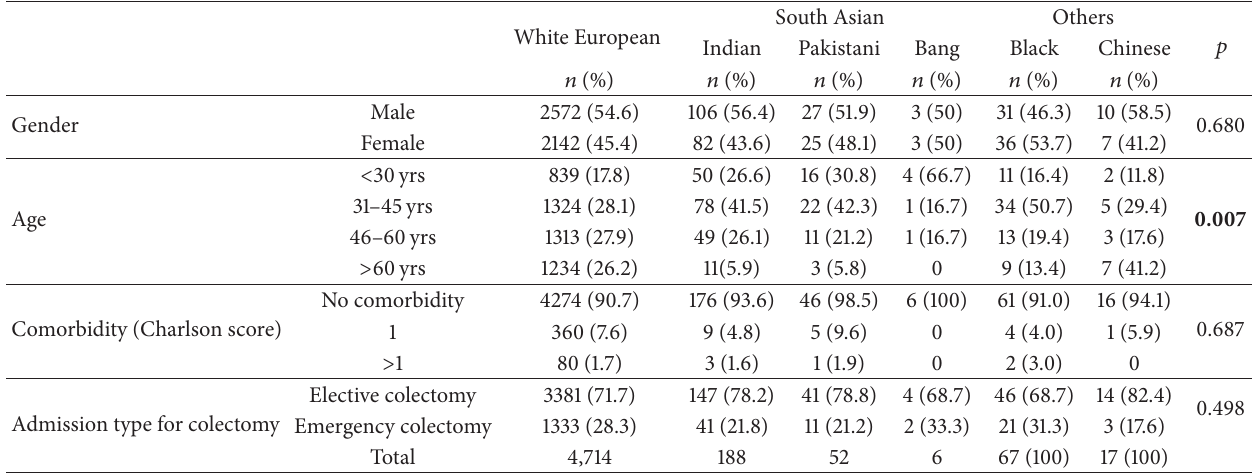
Table 4: Patient demographics for patients that underwent colectomy based on their